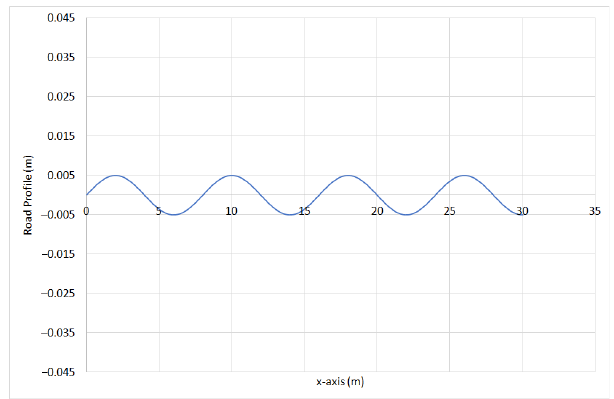
Figure 7. The periodic disturbance.